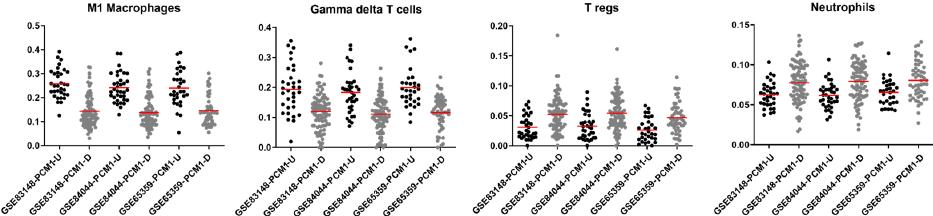
Figure 3. CIBERSORT fractions of M1 macrophages, gamma delta T cells, regulatory T cells and neutrophils within PCM1 ‐ U and ‐ D groups in GSE83148, GSE84044 and GSE65359. Red horizontal line shows the mean value of fractions. Y axis: fraction of immune cells.